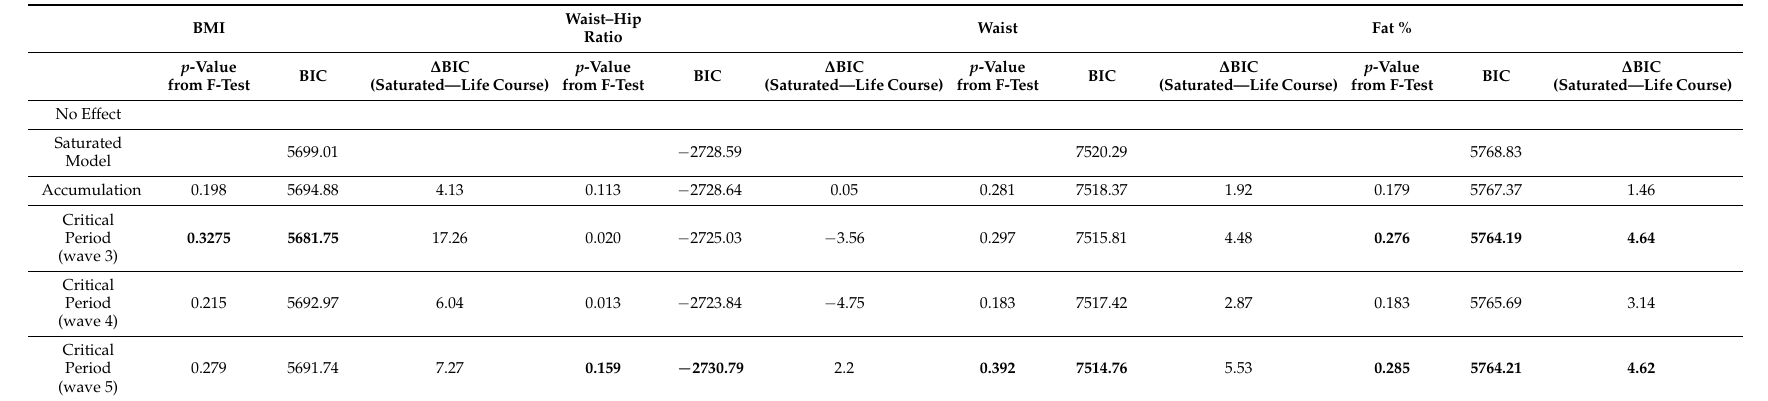
Numbers in bold indicate the best fitting